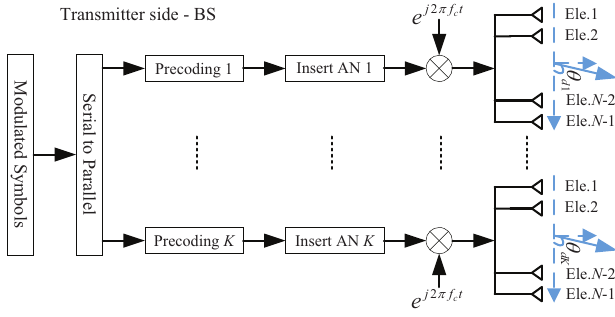
Figure 3. The architecture of the BS for the proposed DM scheme based on a single-carrier multiple antenna arrays